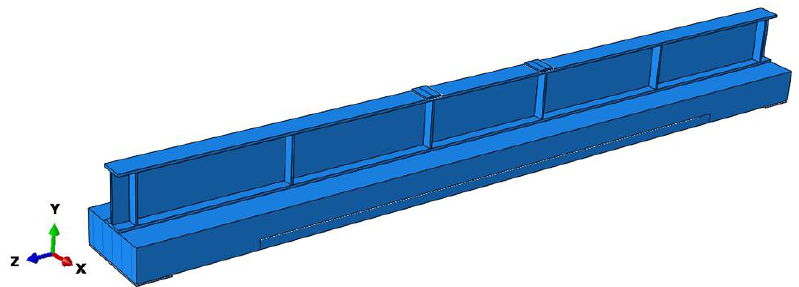
Figure 7. Finite element model.